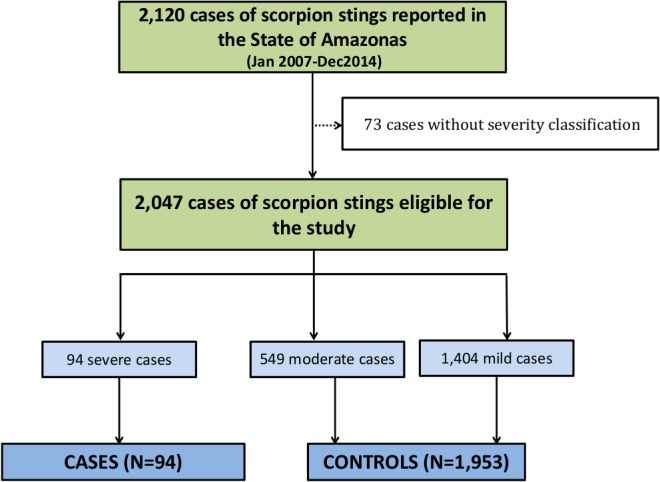
Flow chart of cases and control selection.The selection of cases and controls groups was based on the Brazilian Ministry of Health classification. All severe stings were included as cases, and three mild and moderate stings were in the control group for each case.